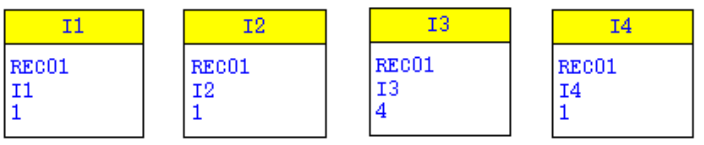
Figure 4. Processing directives for Example 1.